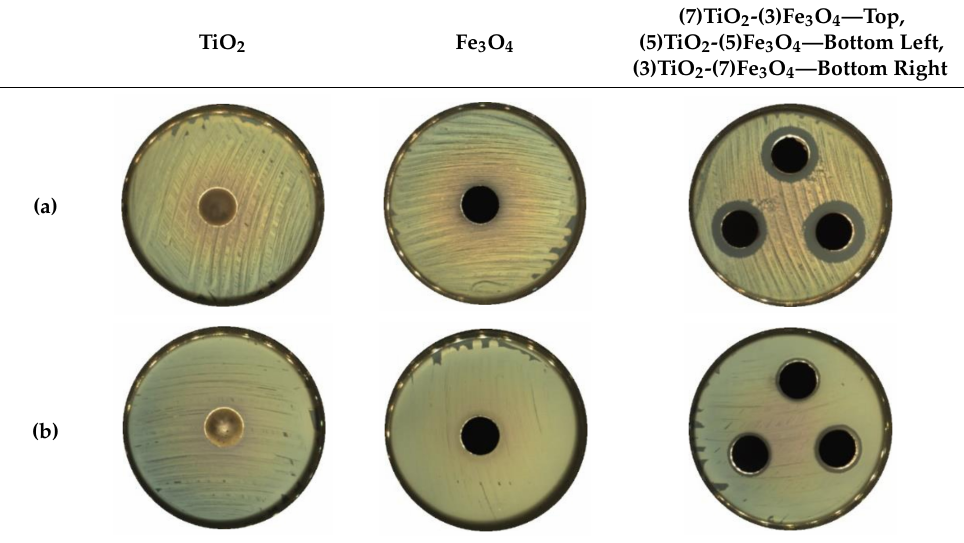
Table 5. Zone of inhibition for Staphylococcus aureus (a) and Escherichia coli (b): agar di ff usion